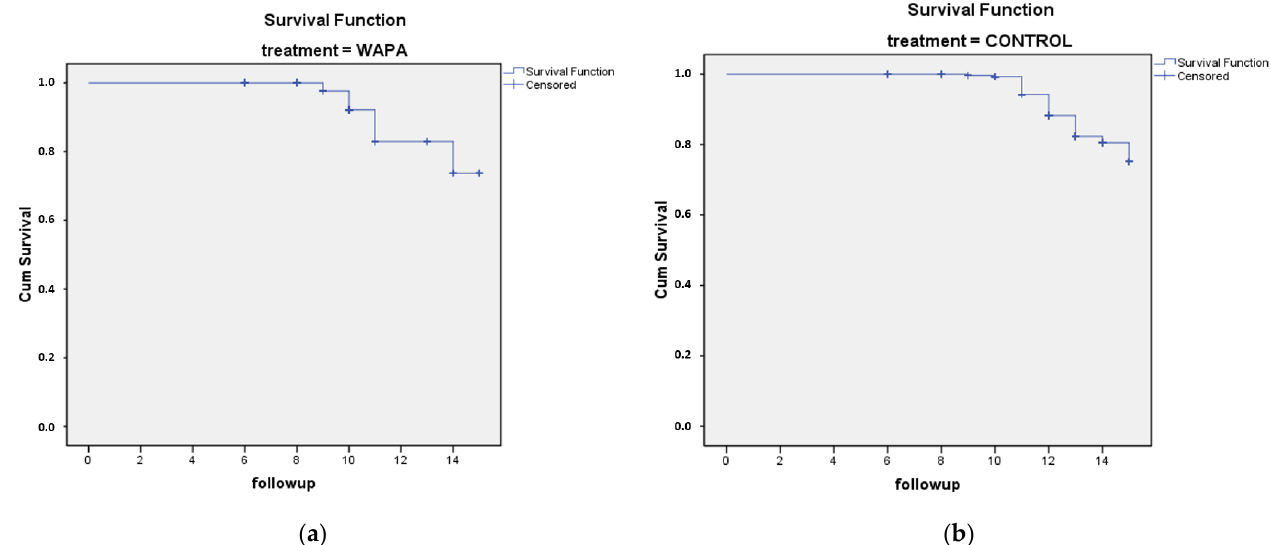
Figure 11. Kaplan–Meier survival analysis of 465 glass–ceramic restorations (131 patients, 59 males, 72 female) for up to 15 years (2003–2018): ( a ) WAPA treatment, n = 183; ( b ) control (non-WAPA treatment), n = 282. For both graphs, the y axis is cumulative survival (%), and the x axis is follow-up (years). The difference was statistically significant (Log Rank test, p < 0.05).